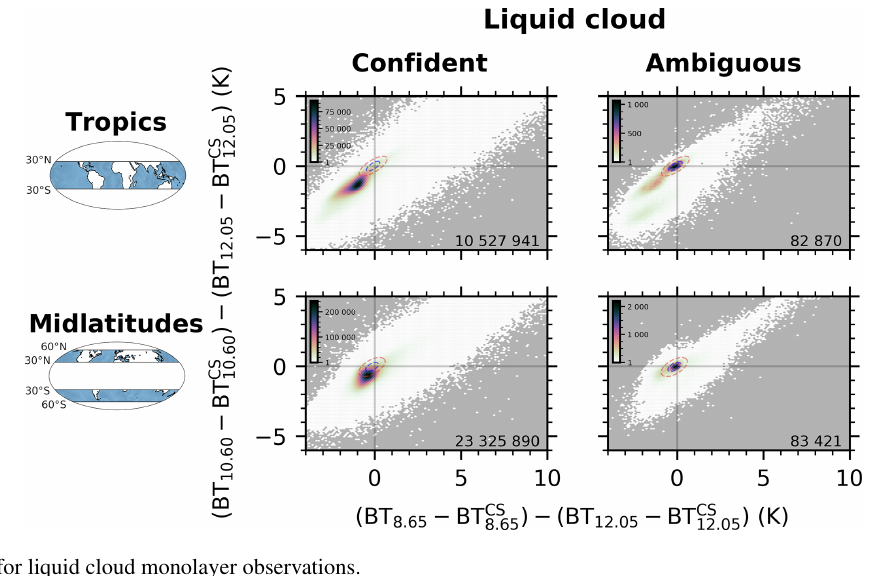
Figure 6. As Fig. 5 for liquid cloud monolayer observations.